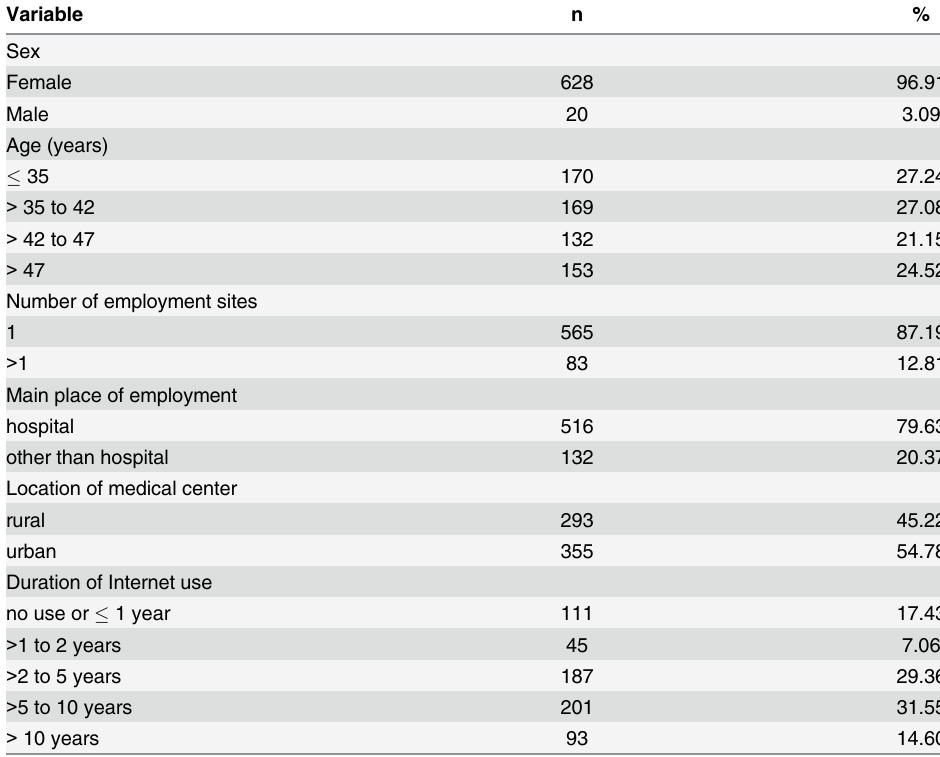
Table 1. Characteristics of the study